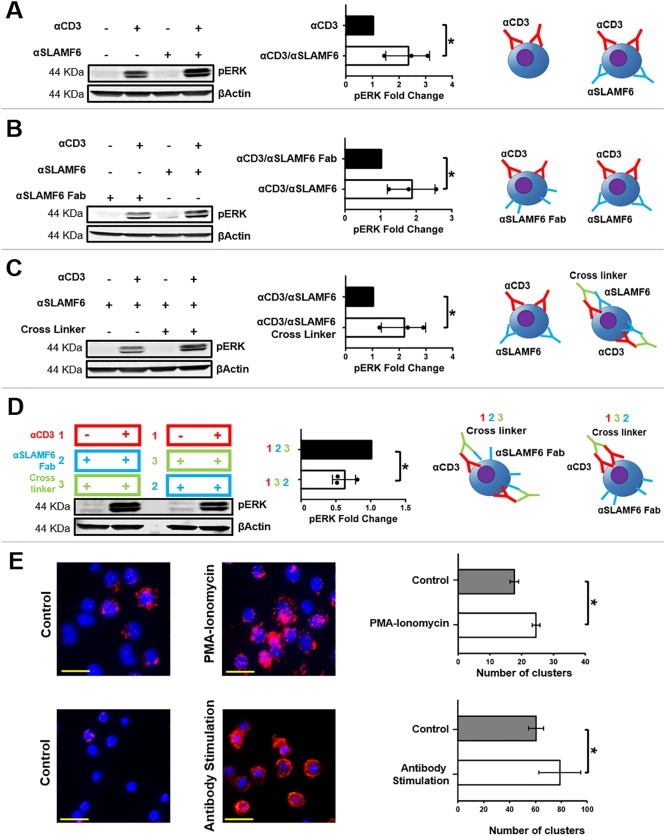
SLAMF6 clustering with the TCR increases T cell activation.(A) Jurkat T cells were treated with αCD3 or αCD3 + αSLAMF6 and then stimulated at 37° C for 5 min. Blots were generated by lysing the cells, separating the lysates by tris-glycine PAGE and transferring to a nitrocellulose membrane. pERK was assessed in three independent experiments (n = 3). *p<0.05 for an unpaired student t-test. (B) Jurkat T cells were treated with αCD3 + αSLAMF6 or αCD3 + αSLAMF6 Fab and then stimulated as above. Blots were generated assessing pERK in three independent experiments (n = 3). *p<0.05 for an unpaired student t-test. (C) Jurkat T cells were treated with αCD3 + αSLAMF6 or αCD3 + αSLAMF6 + cross linker and then stimulated. pERK was assessed in three independent experiments (n = 3). *p<0.05 for an unpaired student t-test. (D) Jurkat T cells were treated with αCD3 + αSLAMF6 Fab + cross linker or αCD3 + cross linker + αSLAMF6 Fab as delineated by color and number (cells were washed in between steps) and then stimulated. Blots were produced for pERK in three independent experiments (n = 3). *p<0.05 for an unpaired student t-test. (E) A proximity ligation assay (PLA) was performed on Jurkat T cells for SLAMF6 and the TCR. Cells were stimulated with PMA ionomycin at 37° C for 5 min, then fixed in 1% PFA for 10 min. Next, the cells were then blocked and treated with αCD3 + αSLAMF6 for 1 hr. at room temperature. This experiment was replicated in freshly isolated primary CD3+ T cells stimulated with immobilized αCD3 + αSLAMF6 for 120 hrs. The PLA assay was then performed as described by the manufactures protocol.